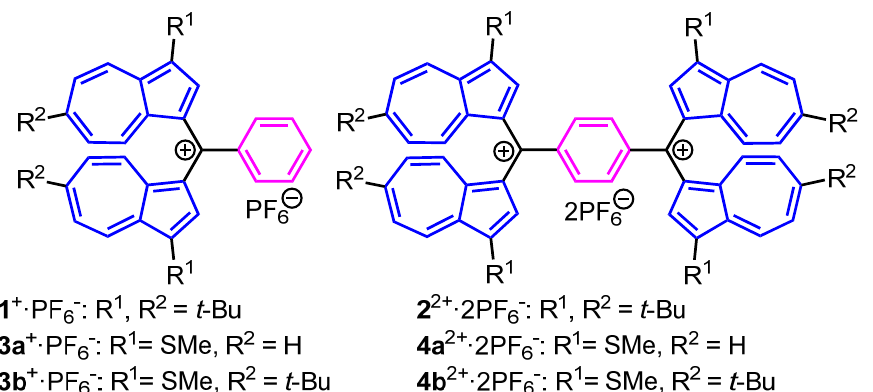
Figure 1. Structures of bis(1-azulenyl)phenylmethylium hexafluorophosphates: 1 + ·PF 6 − and 3a , b + ·PF 6 − and 1,4-phenylenebis[bis(1-azulenyl)methylium] bis(hexafluorophosphate)s; 2 2+ ·2PF 6 − and 4a , b 2+ ·2PF 6 − .